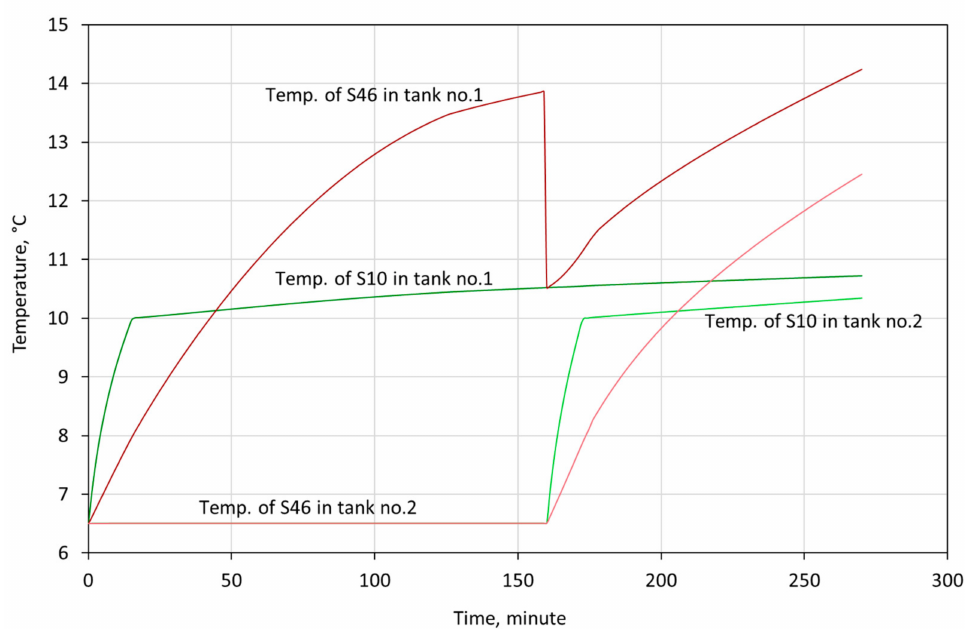
Figure 6. Average temperature of the PCMs in the storage tanks during their discharge.